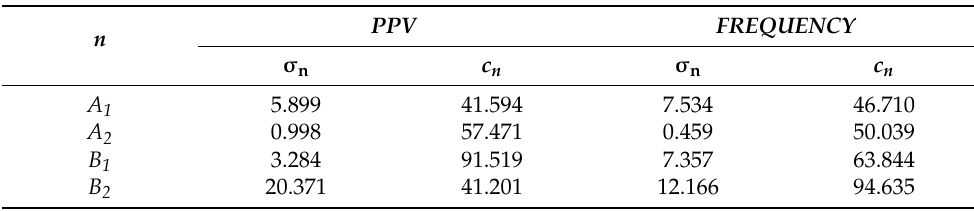
Table 7. Premise parameters of the PPV and FREQUENCY models.